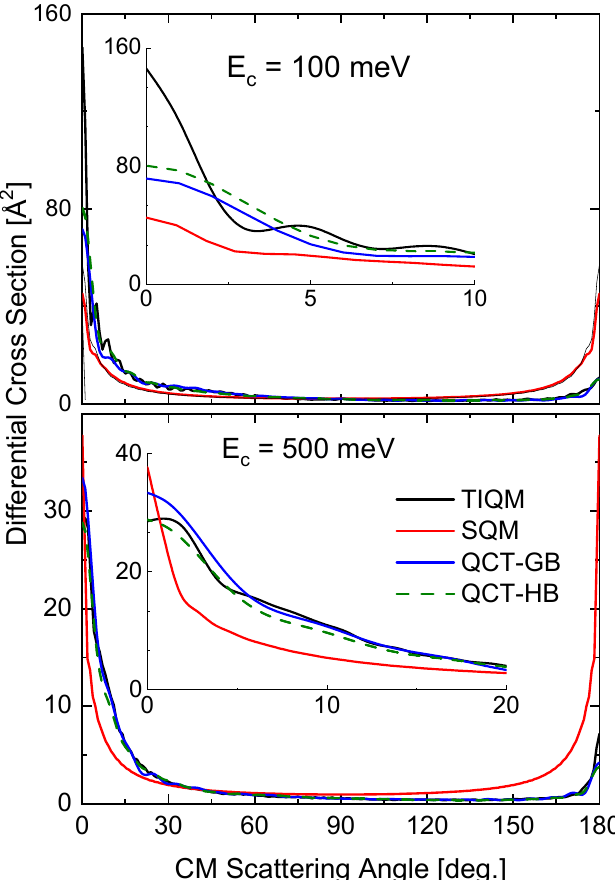
Figure 13. DCSs (in Å 2 ) for the Ne + HeH + ( v , j ) → He + NeH + ( v (cid:48) , j (cid:48) ) reaction at two different values of the collision energy: 100 meV ( top panel ) and 500 meV ( bottom panel ). Comparison of TIQM (black lines), SQM (red lines) and QCT with GB (blue lines) and HB (dashed green lines) results from Ref.